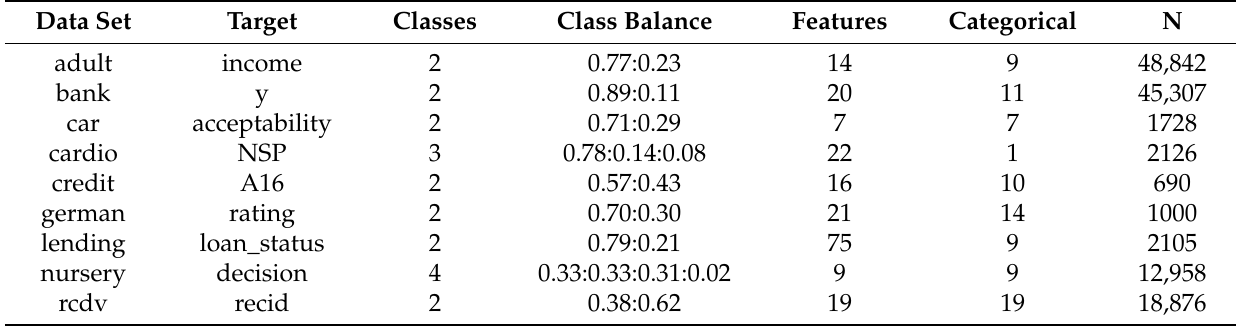
Table 3. Data sets used in the